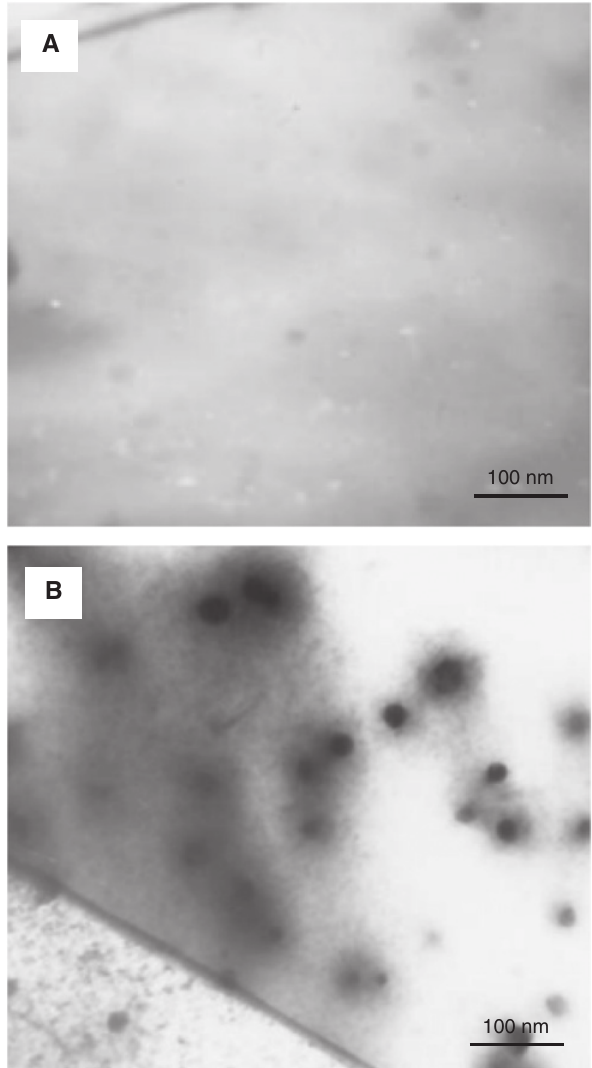
Figure 1: TEM images of the Cu-Cr-Zr-Mo in situ composite solution at 900 ° C for 3 h (A) and aging at 500 ° C for 2 h